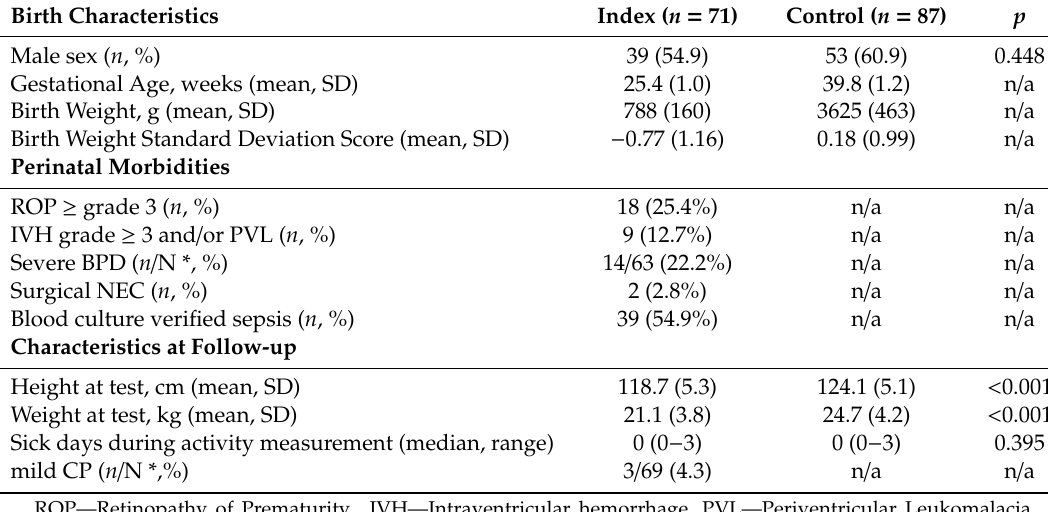
Table 1. Characteristics of study